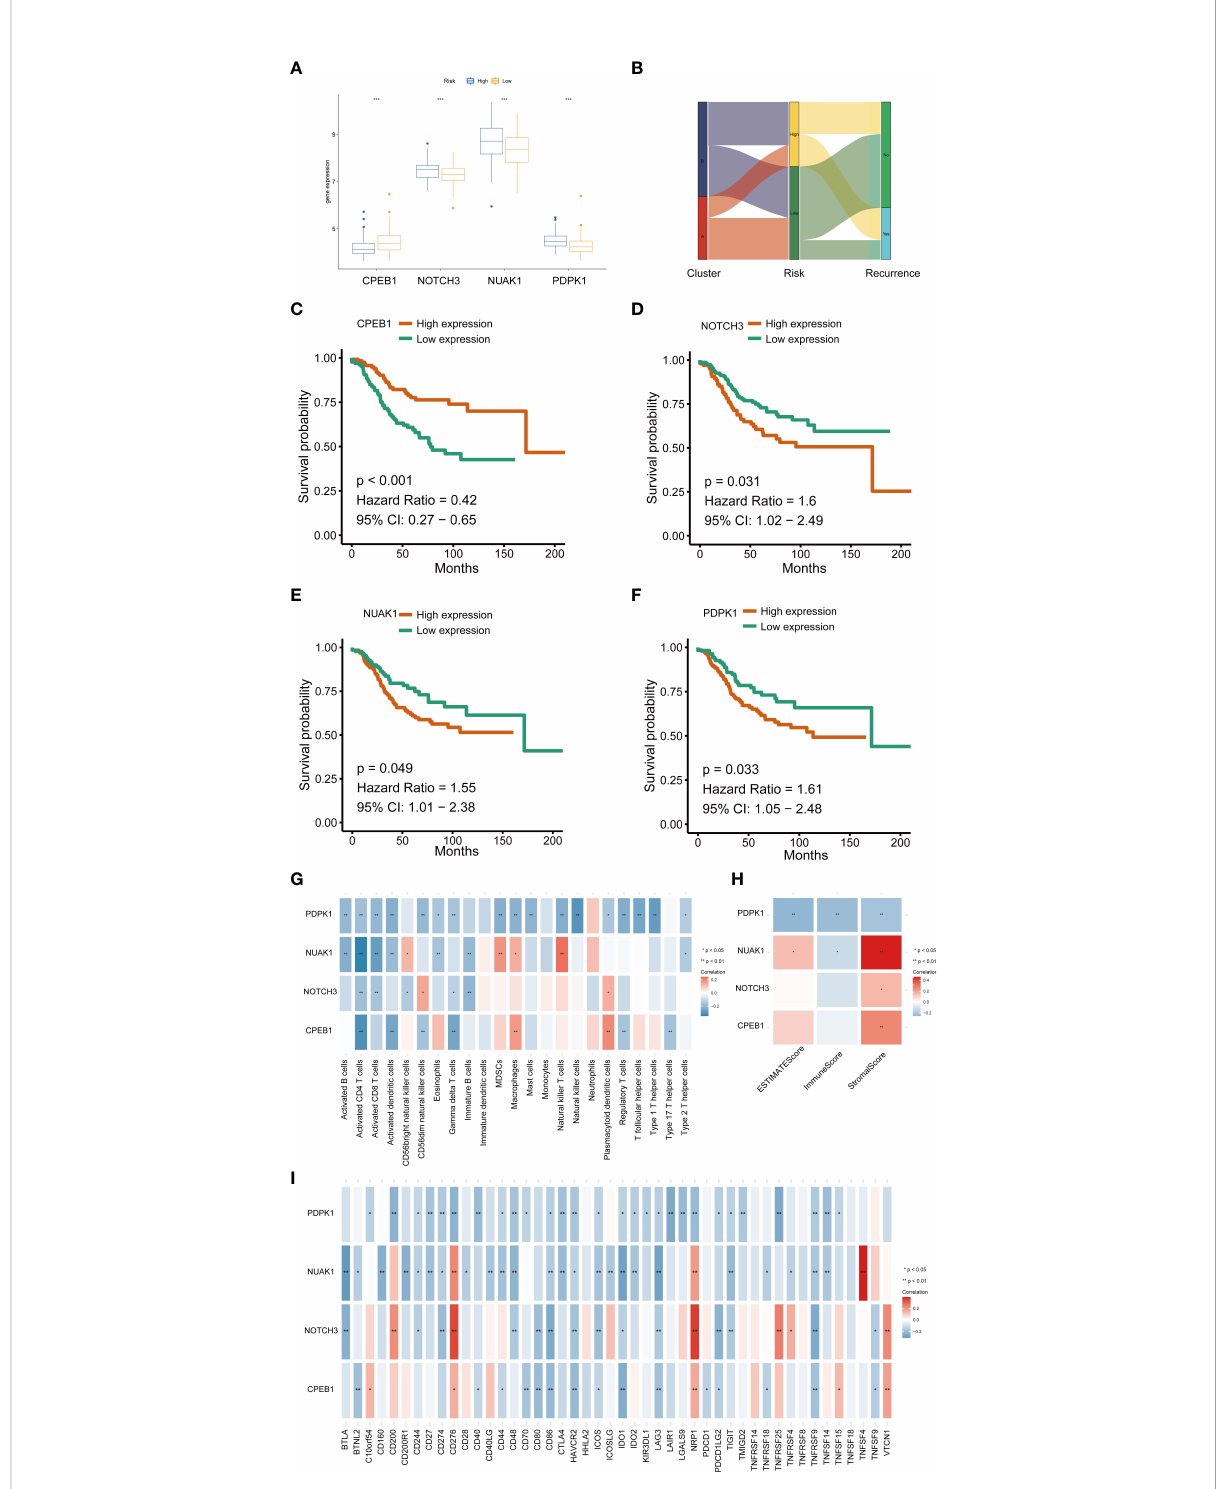
FIGURE 9 The relationships between the four senescence-related genes and prognostics and the correlations of the tumor immune cell microenvironment and the four senescence-related genes. (A) The expression of the four prognostic genes. (B) Sankey diagram. (C – F) Univariate Cox regression analysis of the four prognostic genes in the signature. (G) The correlation between the four genes and activated immune cells. (H) The relationship between the four genes and TME score. (I) The correlation between the four genes and immune checkpoint. * P value < 0.05; ** P value < 0.01; *** P value <